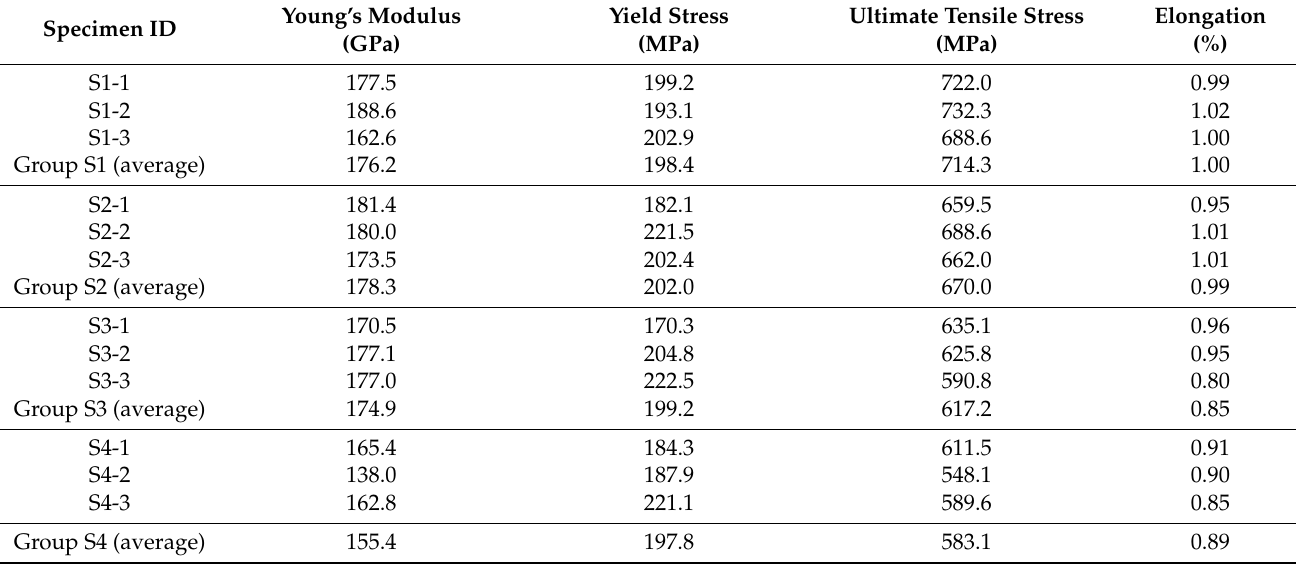
Figure 3. Stress-strain curves of SLM AISI 420 built with various laser spot sizes. Table 4. Tensile properties of SLM AISI 420 built with various laser spot sizes.